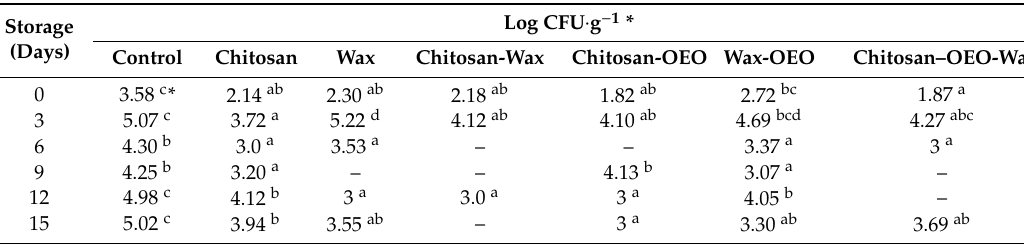
Table 5. Molds and yeast counts of fresh cucumber coated with chitosan, OEO, and carnauba wax and stored 15 days at 10 ◦